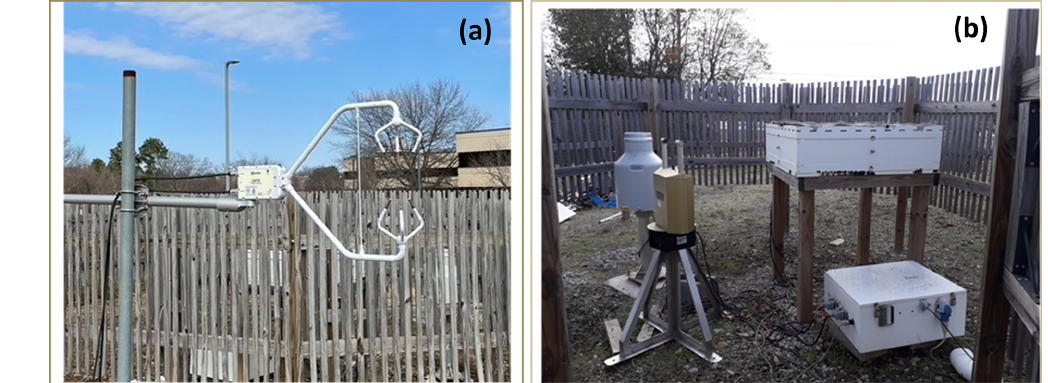
Figure 1. Close-up pictures of (a) the 100Hz sonic anemometer (outside the wind-fence, upwind) and (b) 2DVD:SN16 (inside the double fence), together with Pluvio gauge and other instruments. Note, there is another 2DVD (SN72) outside the double fence a few meters